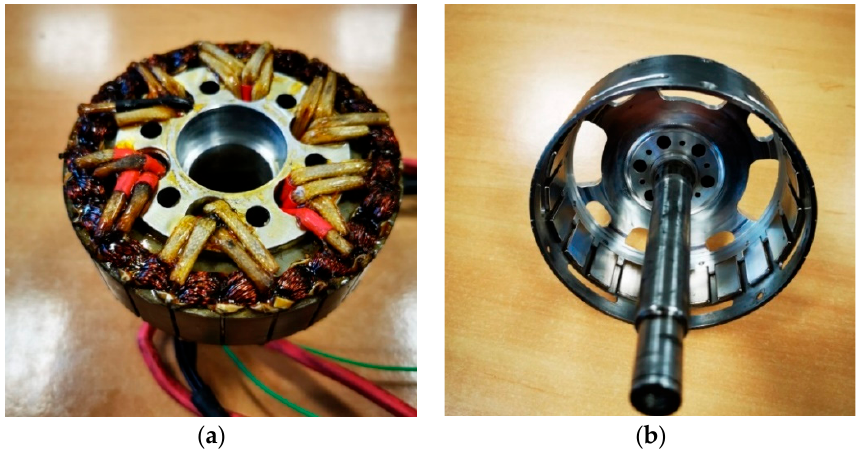
Figure 2. Physical model of the analysed BLDC motor design: ( a ) wound stator with terminals; ( b ) rotor.